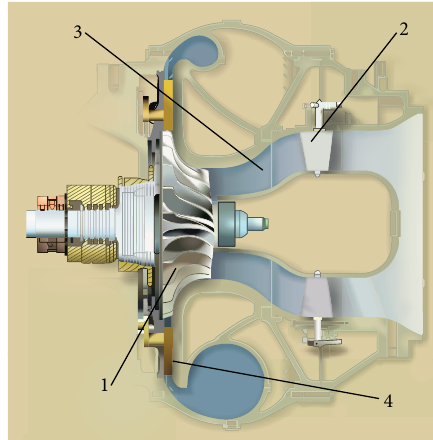
Figure 2: Modern design of centrifugal compressor with VIGV: 1 is impeller, 2 is vane cascade, 3 is annular duct, and 4 is